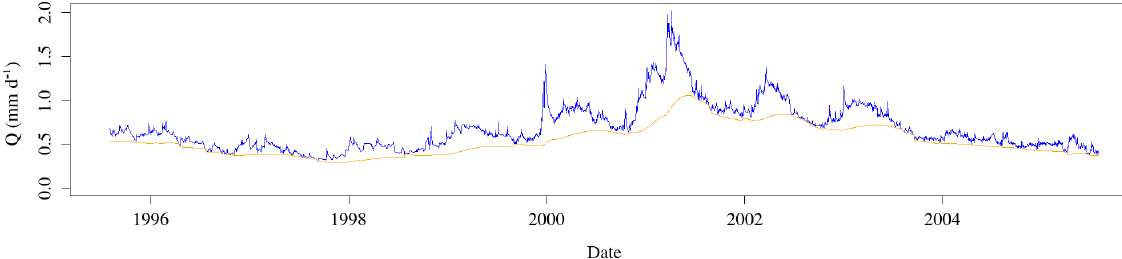
Figure 7. Hydrograph separation of the Petit Thérain River in Saint-Omer-en-Chaussée for